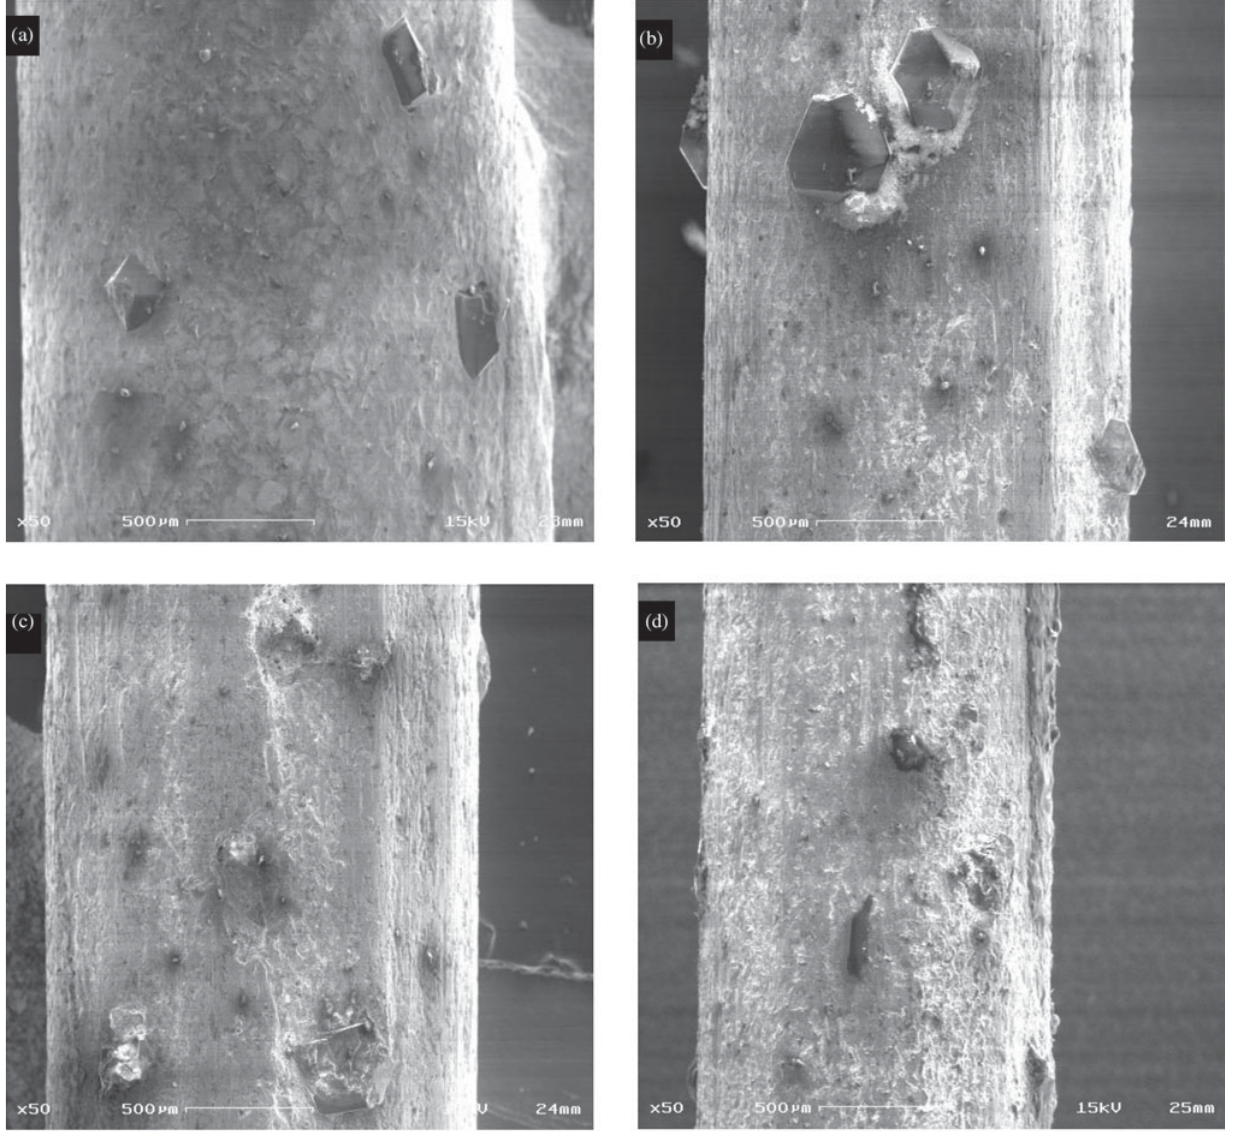
Figure 5. Marble cutting of in situ wire. (a)Before cutting operation, φ = 1.93 mm. (b)After cutting an area of A = 605 cm 2 , φ = 1.61